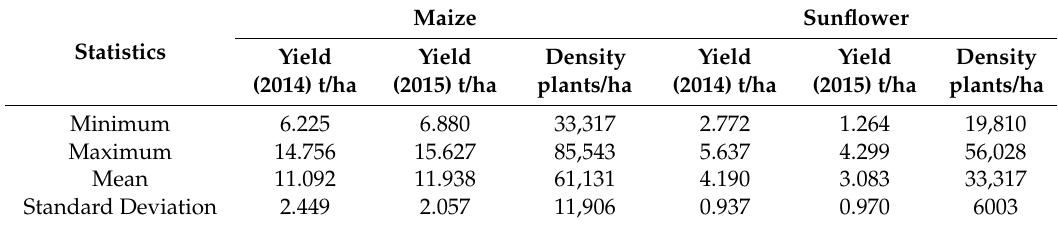
Table 1. Statistics of crop yields at sampling points in Figure 1 in 2014 and